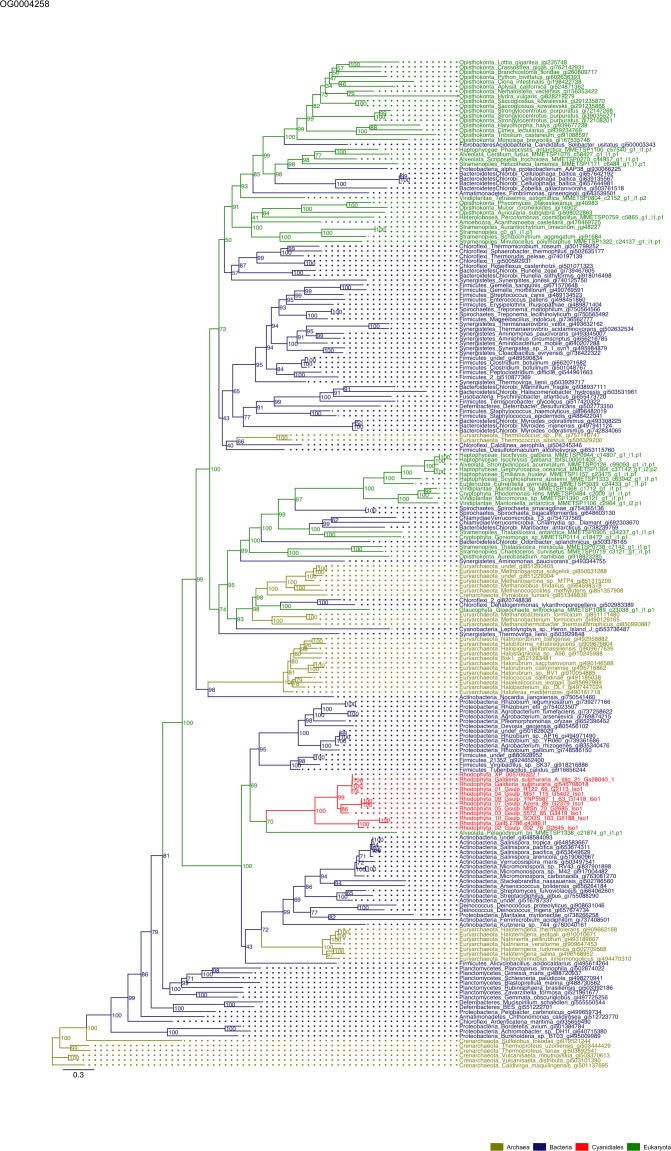
Sequence tree of orthogroup OG0004258.The tree is based on amino acid sequences. Archaea (yellow), Bacteria (blue), Cyanidiales (red), Eukaryotes including other red algae (green). Branches containing Cyanidiales sequences are highlited in red.